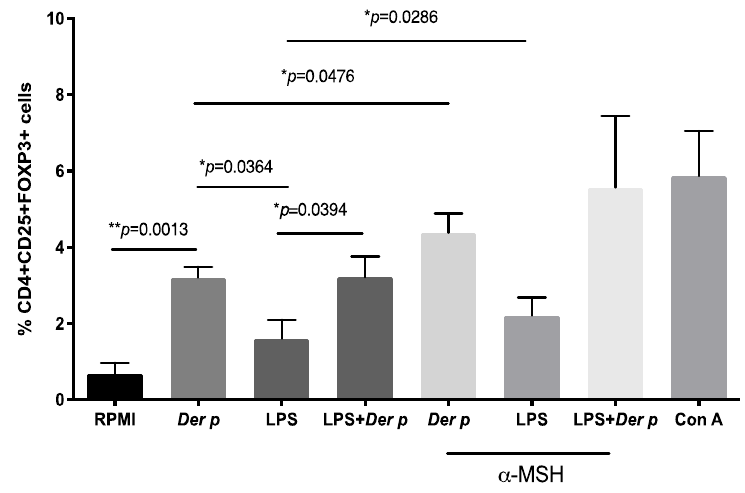
Figure 3. Frequency of T regulatory CD4 + CD25 + FOXP3 + cells in CD4 + T cells after 72 h of culturing Figure 3 . Frequency of T regulatory CD4+CD25+FOXP3+ cells in CD4+T cells after 72 h of culturing with Der p and LPS. See Figure S1 for α -MSH dose-response experiments. * p ≤ 0.05; ** p ≤ with Der p and LPS. See Figure S1 for α-MSH dose-response experiments. * p  0.05; ** p  0.01